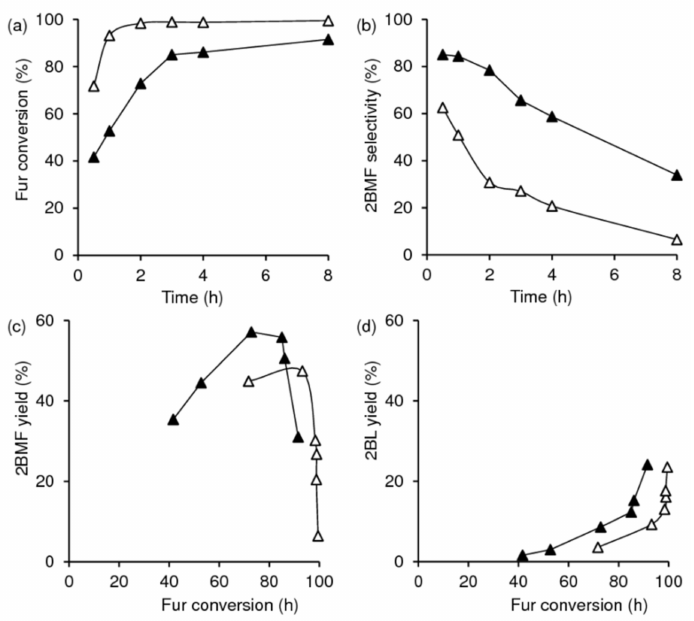
Figure 6. Comparison of the Hf-TUD-1(50) ( (cid:78) ) and Zr-TUD-1(50) ( ∆ ) catalysts: kinetic profile of Fur ( a ); 2BMF selectivity dependency on reaction time ( b ); and the dependencies of the yields of 2BMF ( c ) and 2BL ( d ) on Fur conversion at 150 ◦ C. Reaction conditions: 0.2 M Fur in 2BuOH, 20 g cat L − 1